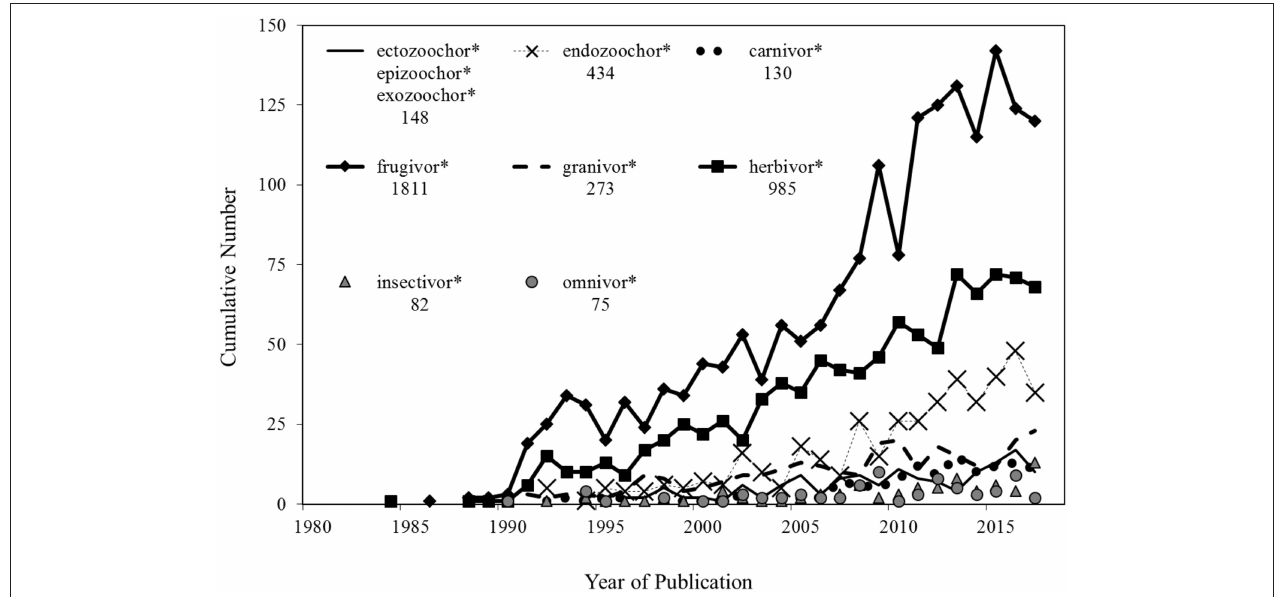
FIGURE 1 | The annual cumulative number of zoochory-related publications cataloged within the on-line scientific database Thomson-Reuters Web of Science , 1st January 1980–31st December 2017. Data were extracted through a Topic Search using the zoochorous and dietary terminologies shown, which were combined with the additional search terms of “seed,” “propagule,” “dispersal,” and “dispersion” to create a search string. For example: (endozoochor*) AND (seed OR propagule) AND (dispersal OR dispersion). The total number of publications for each examined search string are shown. Ectozoochor* was combined with frequently used synonyms, epizoochor*, and